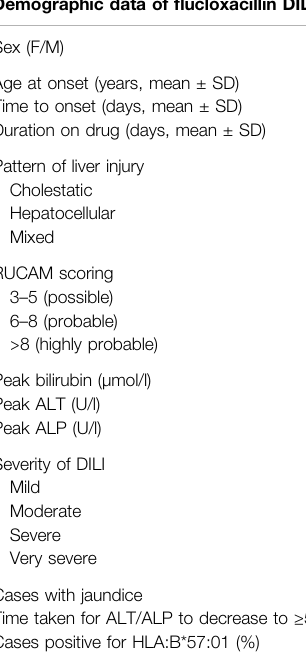
TABLE 1 | Clinical and biochemical variables in DILI patients exposed to fl ucloxacillin. Demographic data of fl ucloxacillin DILI participants ( n =